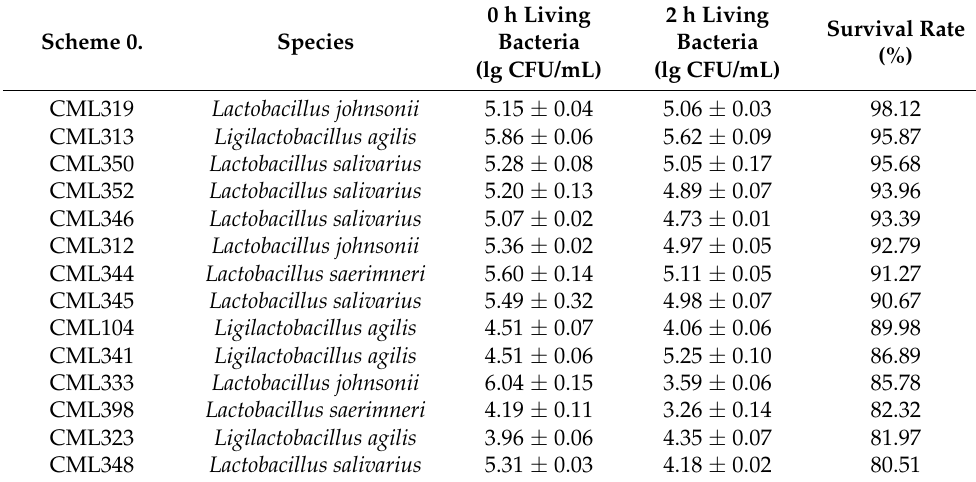
Table 4. Survival rate of different Lactobacillus strains under pH = 3.